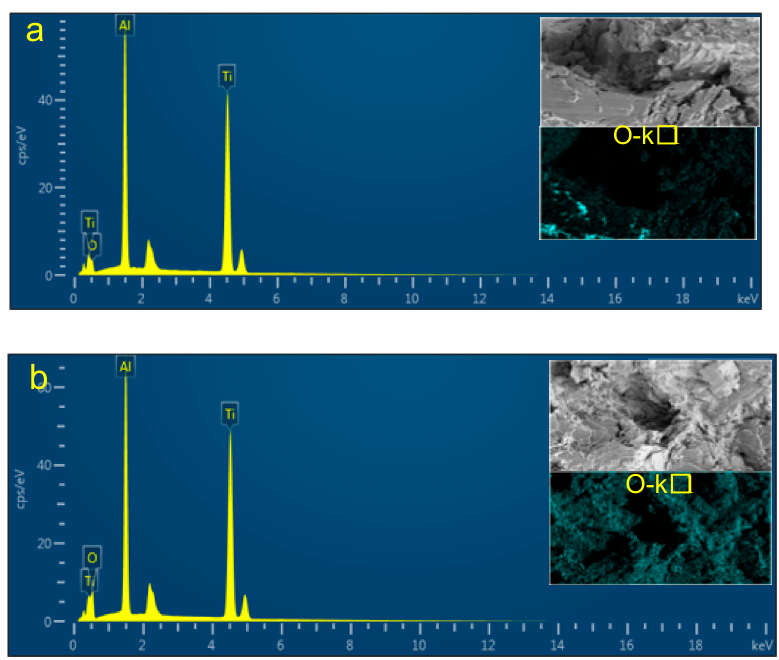
Figure 9. Energy dispersive analysis of typical fracture surfaces ( a ) at 400 °C and ( b ) at 750 °C by EDS.